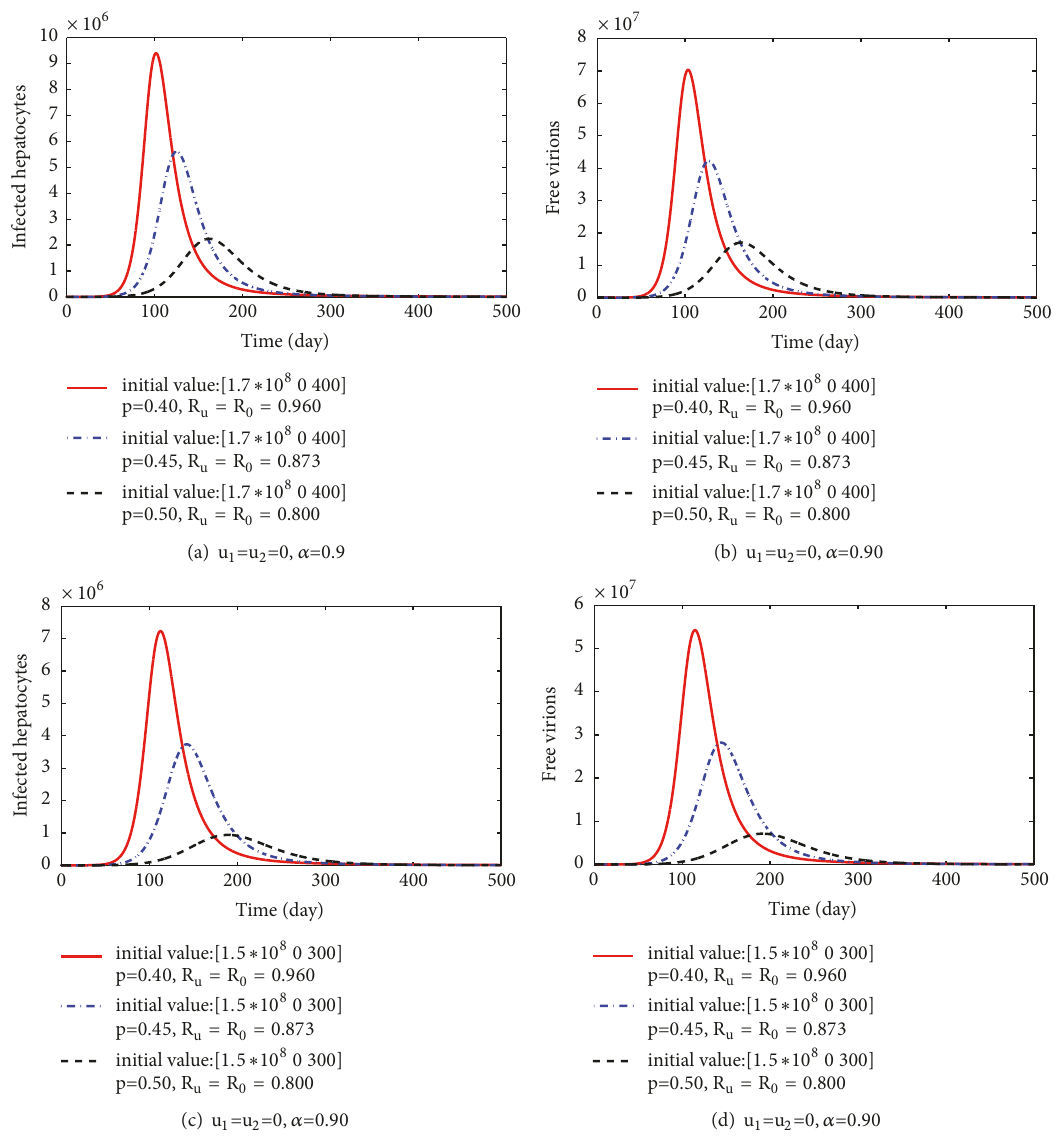
Figure 1: Dynamics of system (3) for different values of 𝑝 , which shows that the disease-free equilibrium 𝐸 0 𝑢 = (Π/𝛿, 0, 0) = (1.667×10 8 ,0,0) is stable when 𝑅 𝑢 = 𝑅 0 < 1 , where 𝛼 = 0.90 . The initial conditions of (a) and (b) are as follows: [ 1.7 × 10 8 0 400]; the initial conditions of (c) and (d) are as follows: [ 1.5 × 10 8 0